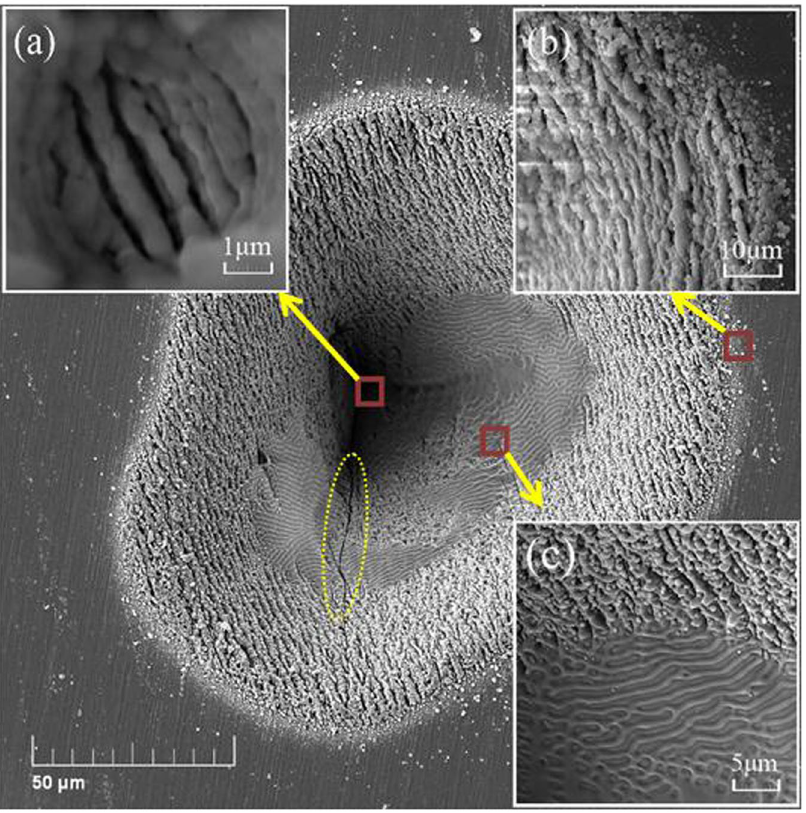
Figure 5. High resolution SEM micrograph of As 2 Se 3 damage crater at 30 mW. The inset image ( a ) shows boundary between melting and electron damage. The inset image ( b ) shows edge of electron damage. The inset image ( c ) shows bottom of damage crater. A crack is marked in yellow dotted line circle.